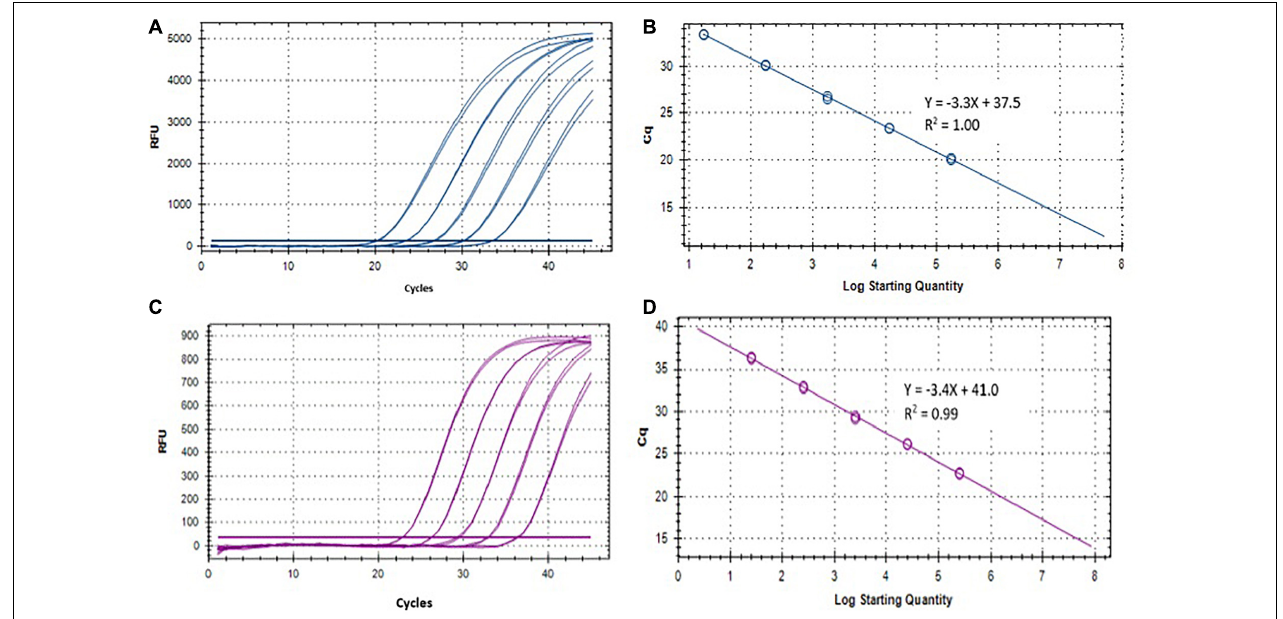
FIGURE 3 | Performance of S. Typhi and S. Paratyphi A qPCR assays described by Karkey et al. (2016) and DNA standards. (A) Amplification of 10-fold serially diluted S. Typhi DNA standard. (B) Standard curve of S. Typhi DNA. (C) Amplification of 10-fold serially diluted S. Paratyphi A DNA standard. (D) Standard curve of S. Paratyphi A DNA.